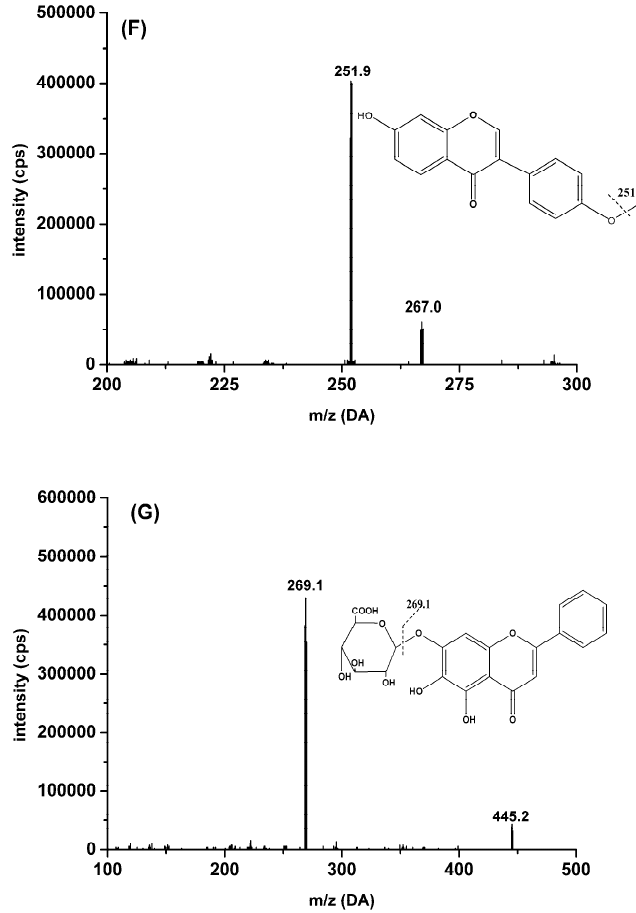
Figure 1. Chemical structures and full scan product ion of precursor ions of cynaroside ( A ), quercetin ( B ), luteolin ( C ), isorhamnetin ( D ), rutin ( E ), formononetin ( F ) and baicalin ( G ; IS).